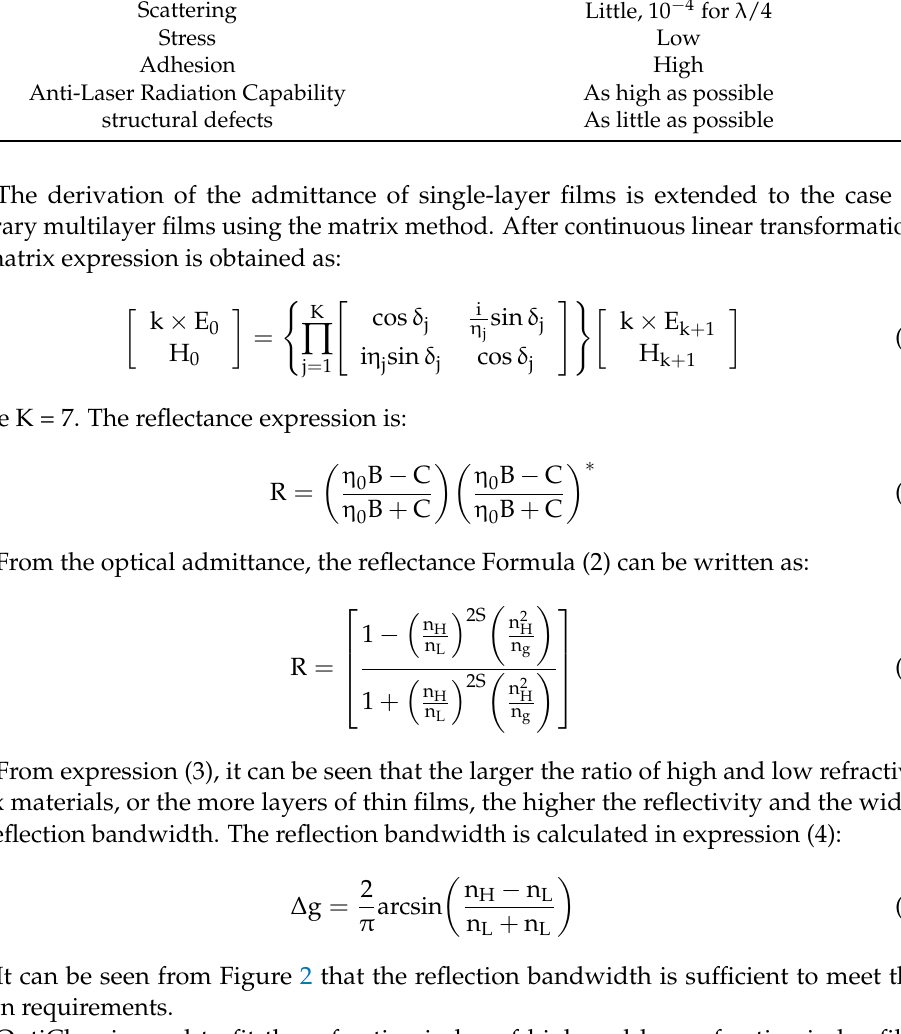
Table 4. Requirements for the characteristics of dielectric film materials. Characteristic Requirment Refrective index Uniform, repeatable Reflectance High, k < 10 − 4 Scattering Little, 10 − 4 for λ /4 Stress Low Adhesion High Anti-Laser Radiation Capability As high as possible structural defects As little as